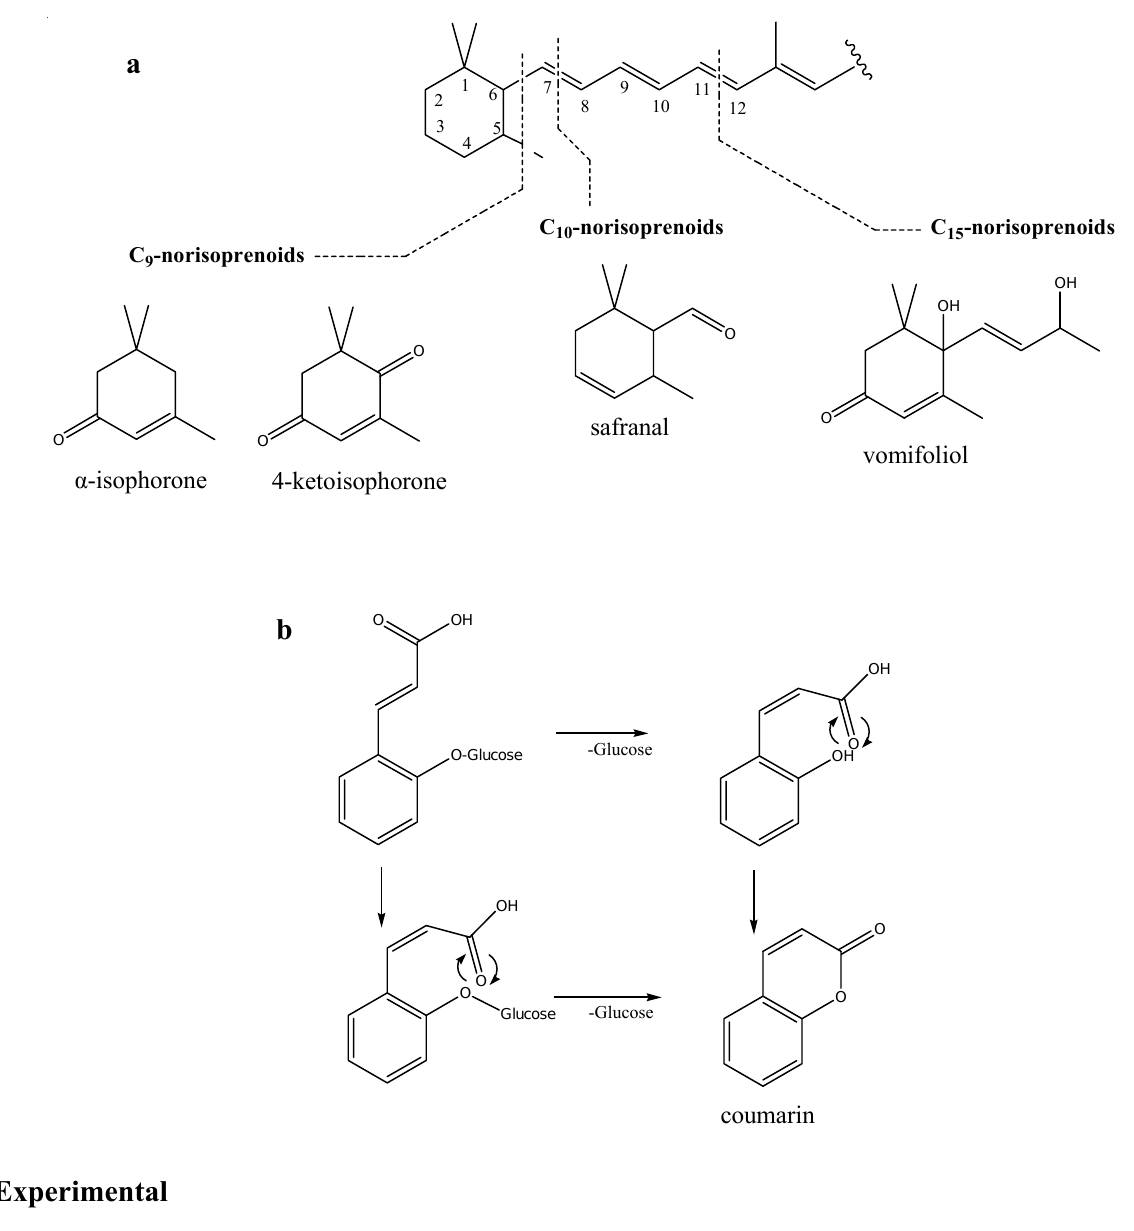
Figure 1. (a) Structures of identified norisoprenoids derived from carotenoids. (b) Biosynthesis of coumarin from the corresponding